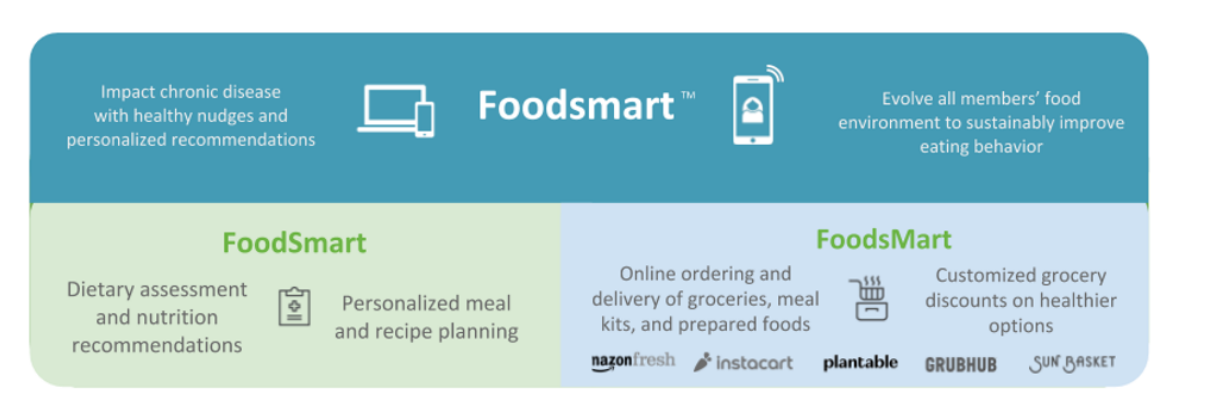
Figure 1. Components and tools of